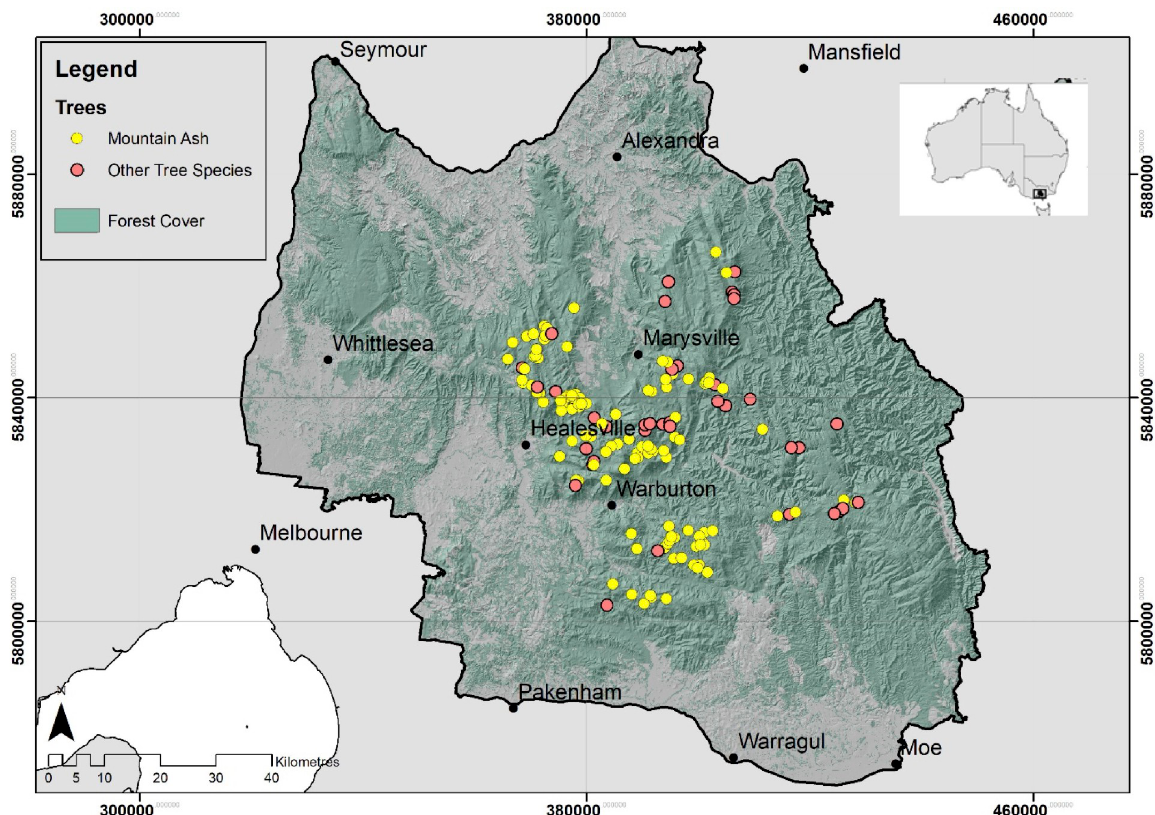
Fig 1. The location of study sites that were surveyed by spotlighting in the Central Highlands of